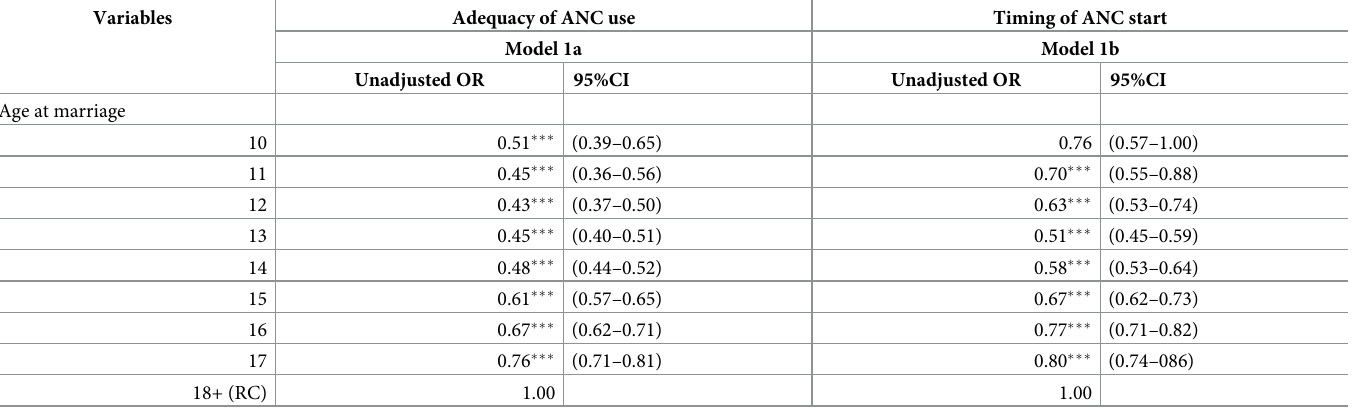
Table 4. Logistic regression model examining the influence of age at first marriage on adequacy and timing of first ANC among young married women in selected SSA countries.